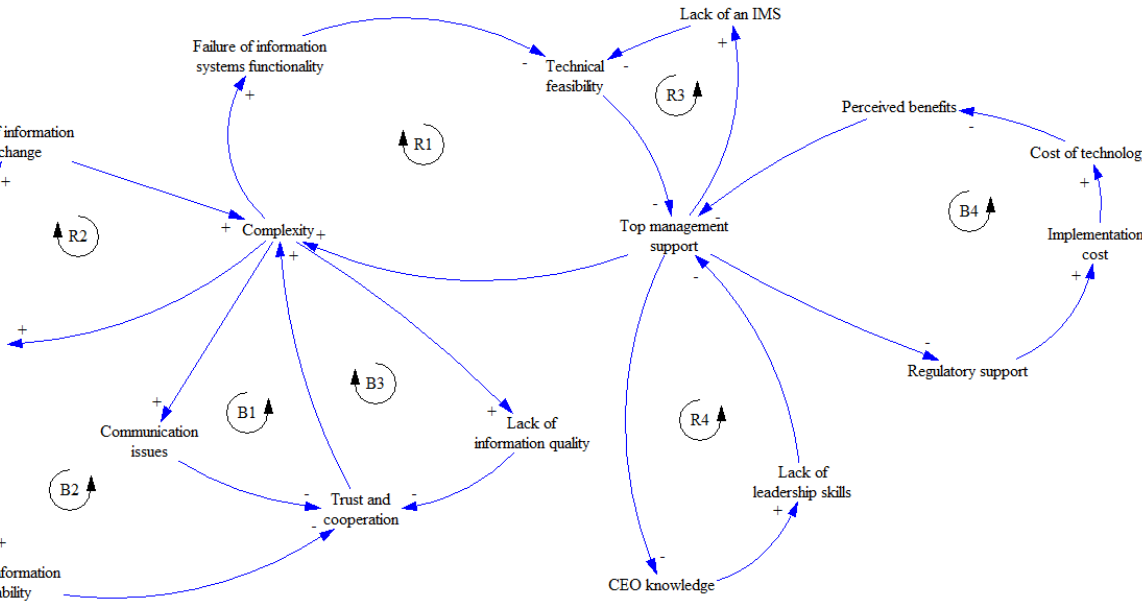
Figure 4. Loop R1. 4.1.2. Reinforcing Loop R2 The loop (R2) shows that ‘Lack of information exchange’ increases complexity, lead- ing to a corresponding increase in security issues, as evident from Figure 5. Thus, an in- crease in security issues increases the lack of information exchange in CSCs.